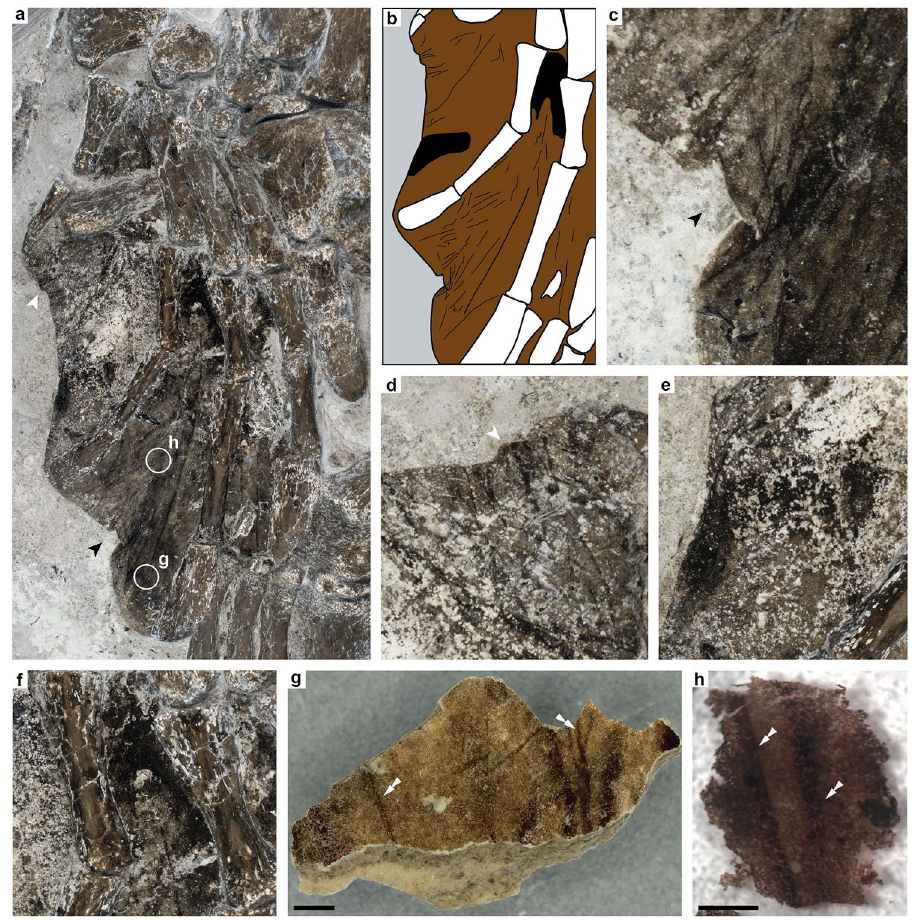
Figure 2. Structure of DK 807 hind limb soft tissues. ( a ) Photograph of the right hind flipper of DK 807. Approximate areas from where samples were taken from the counterslab for analysis are demarcated by white circles ( g , h ). ( b ) Sketch image of some key features of the flipper, with brown indicating epidermal tissues, grey sediment, white bone, and black dermal remains. Lineations are interpreted as folded tissue residues. ( c , d ) Close-up photographs of multiple skin folds. The locations of these folds are denoted by corresponding arrows in ( a ). ( e , f ) Patches of concentrated black matter within the flipper soft tissue, interpreted as dermal residues. ( g ) Image of sampled flipper residue demineralized using EDTA. ( h ) Photograph of a liberated sheet of organic matter following treatment with hydrofluoric acid. Note multiple lineations (folded tissue residues) denoted by white double arrowheads in ( g ) and ( h ). Scale bars, 1 mm ( g , h